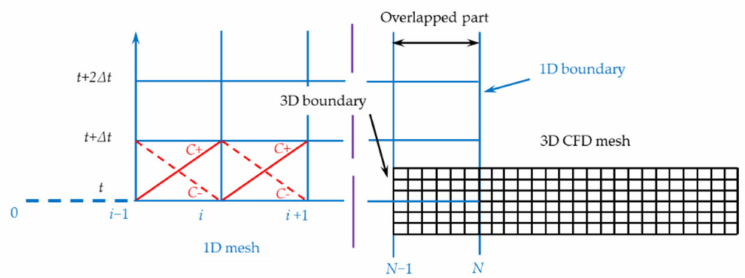
Figure 3. Schematic diagram of overlapped meshes between 1D and 3D